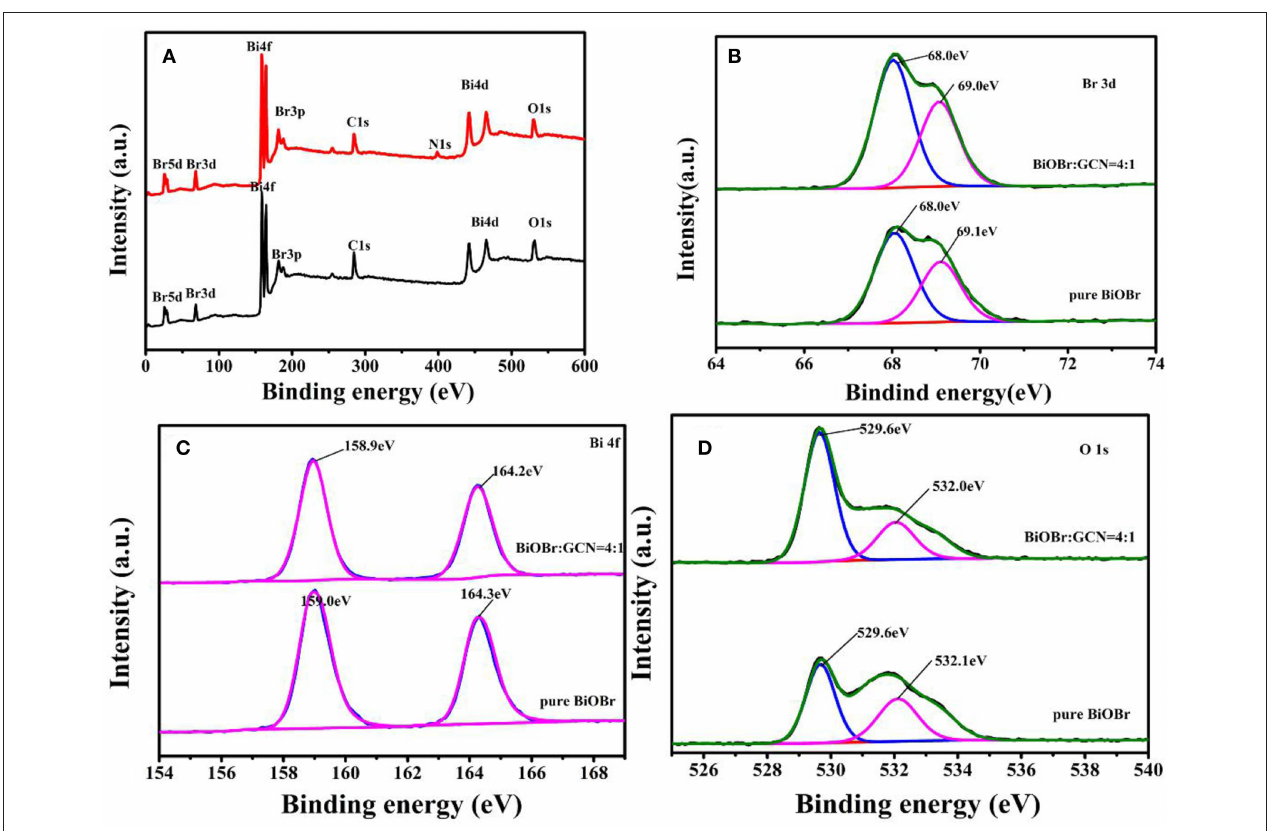
FIGURE 3 | XPS spectra of pure BiOBr and BiOBr-g-C 3 N 4 -4:1 composite; (A) survey, (B) Br 3d, (C) Bi 4f, and (D) O1s.